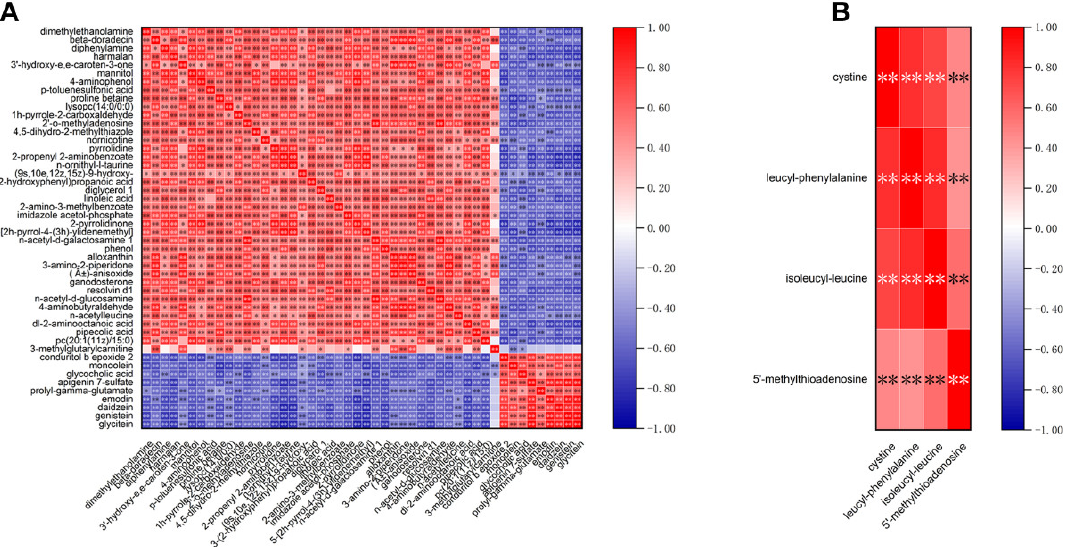
Figure 5. Correlation heatmaps of differential metabolites induced by domestication ( A ) and boiling ( B ). Each square indicates r (Spearman’s correlation coefficient value for a pair of metabolites). Positive (0 < r ≤ 1) correlations are shown in red, and negative ( − 1 < r < 0) correlations are in blue (* 0.01 ≤ p < 0.05, ** p < 0.01).